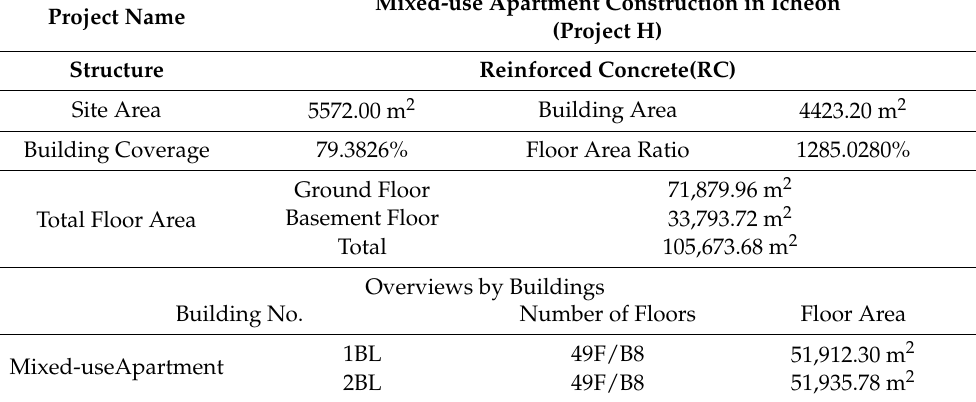
Table A5. Overview of Construction Project